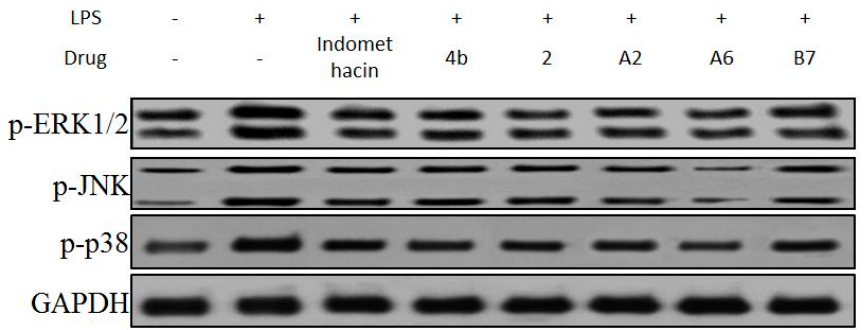
Figure 9. Immunoblotting of p-ERK1/2, p-p38, and p-JNK of MAPK signaling pathway in RAW264.7 cells treated with 10 μ M compound 4b , 2 , A2 , A6 , and B7 , or indomethacin. GAPDH was used as a loading control.